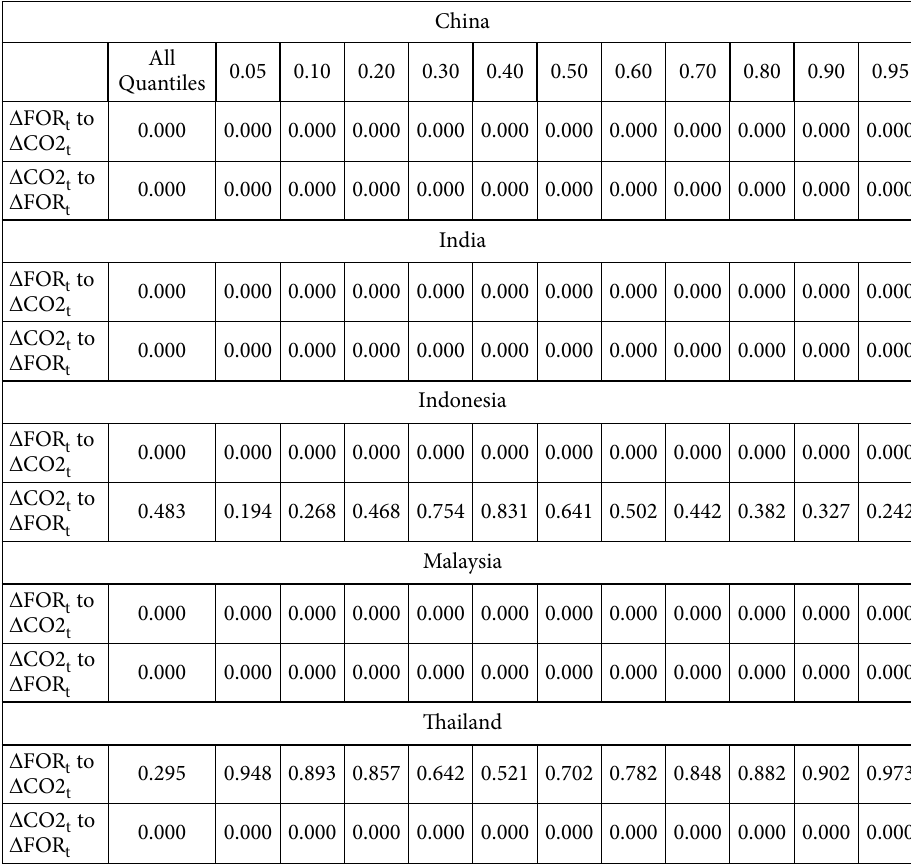
Table 4. Granger causality in quantile test results (source: authors estimation)